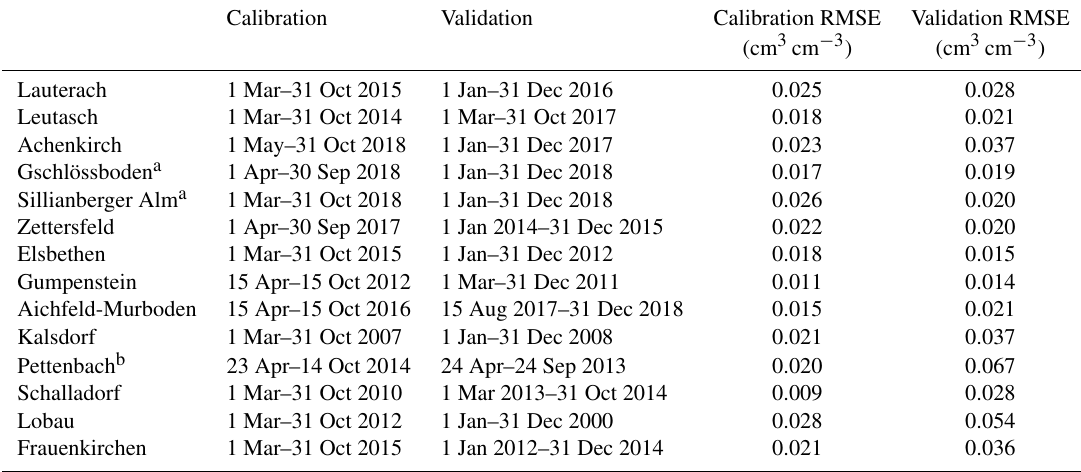
Table A2. Calibration and validation periods, showing the goodness of fit (root-mean-square error, RMSE) between the median prediction and measurements.